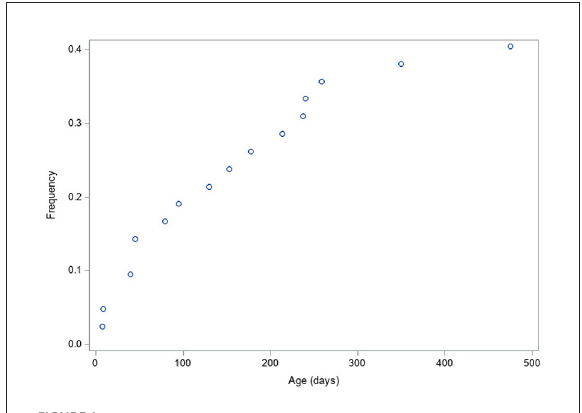
FIGURE1 Proportion of patients presenting a fUTI according to age at first